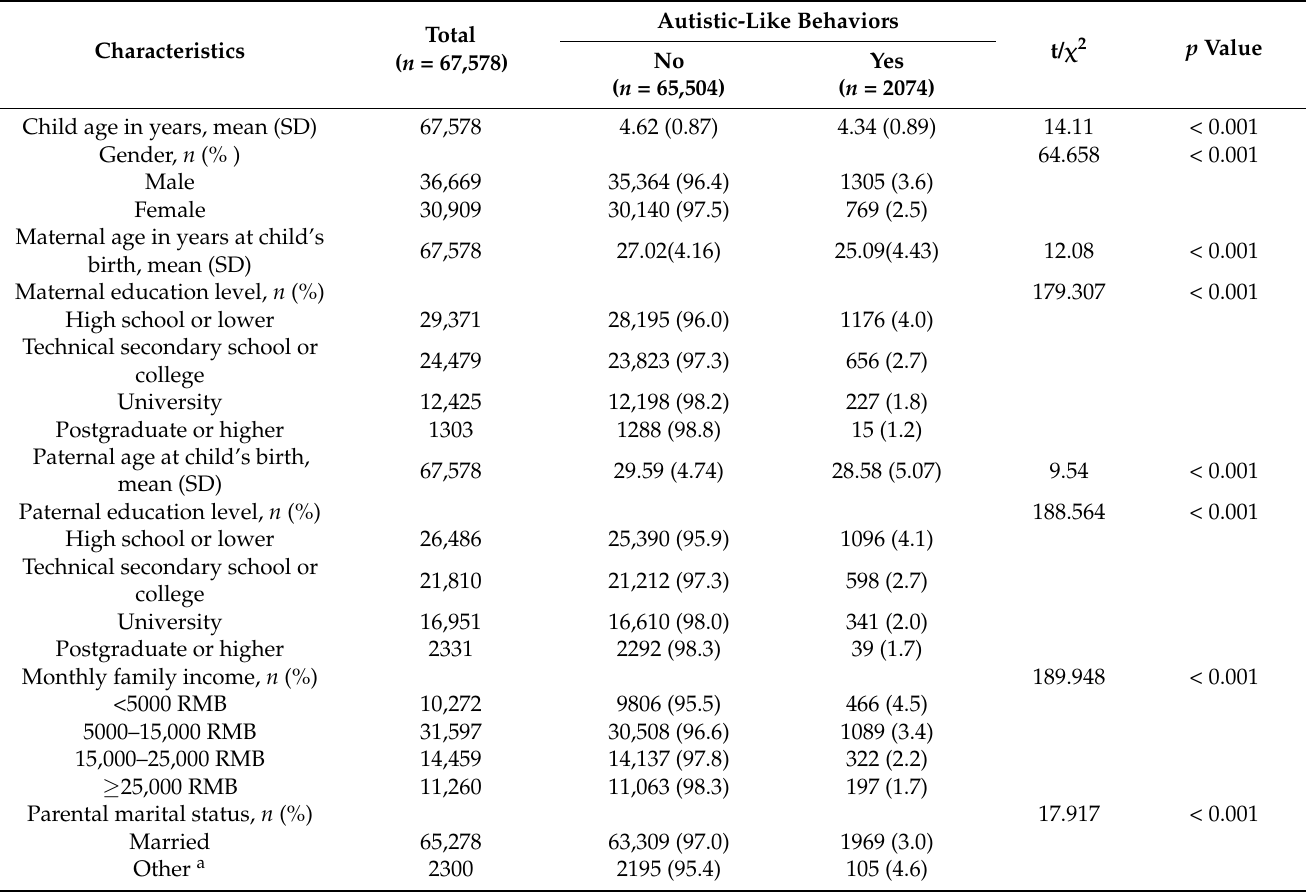
Table 3. Autistic-like behaviors of preschool children in different socio-demographic characteristics # .